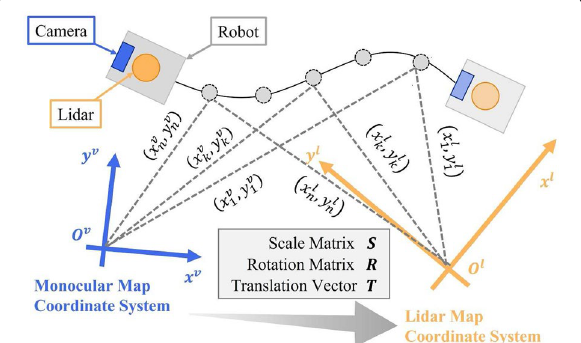
Fig. 4 Conceptual image of automatic calibration utilizing robot trajectory in two coordinate